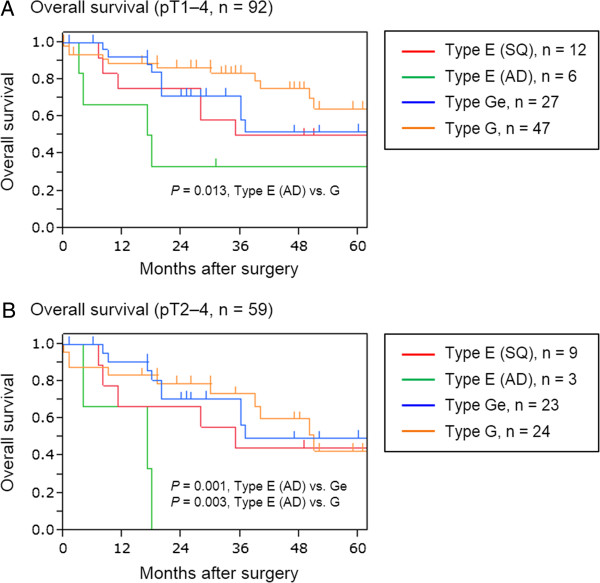
Overall survival of patients. (A) Patients with pT1–4 tumors (n = 92). Type G tumor group demonstrated higher overall survival rate compared with type E adenocarcinoma (AD) (P = 0.013) tumor group. Although not significantly, the type G tumor group had a higher survival rate than the type E squamous-cell carcinoma (SQ) (P = 0.366) and Ge (P = 0.850) tumor group. (B) Patients with pT2–4 Tumors (n = 59). The type E (AD) tumor group demonstrated significantly lower overall survival rate compared with the type Ge (P = 0.001) and type G (P = 0.003) tumor group. The type E (AD) tumor group had a lower survival rate than the type E (SQ) tumor group (P = 0.076) although not significantly.